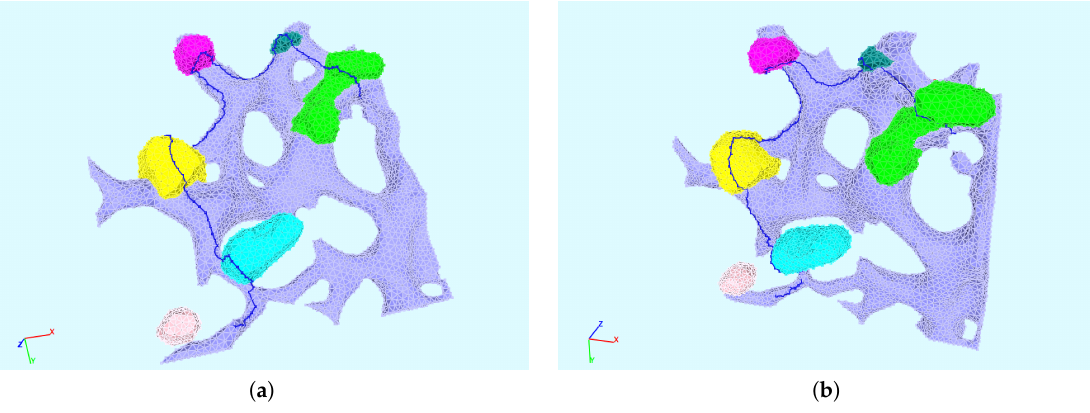
Figure 2. Evaluation of the concentrations along the shown pathways (two perspectives of the path: path indicated by lines in blue, starting from the upper right direction anti-clockwise). ( a , b ) show the geometry/the path from slightly changed